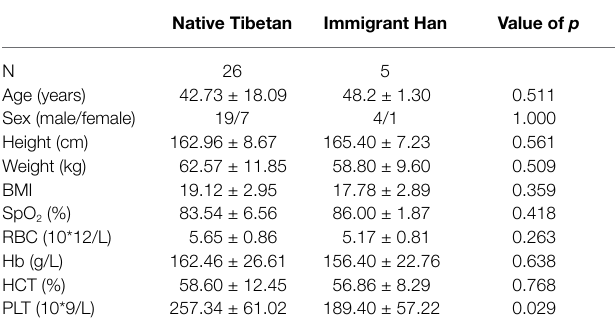
TABLE 1 | Characteristic of the native Tibetans and Han immigrants in Da Ri. Native Tibetan Immigrant